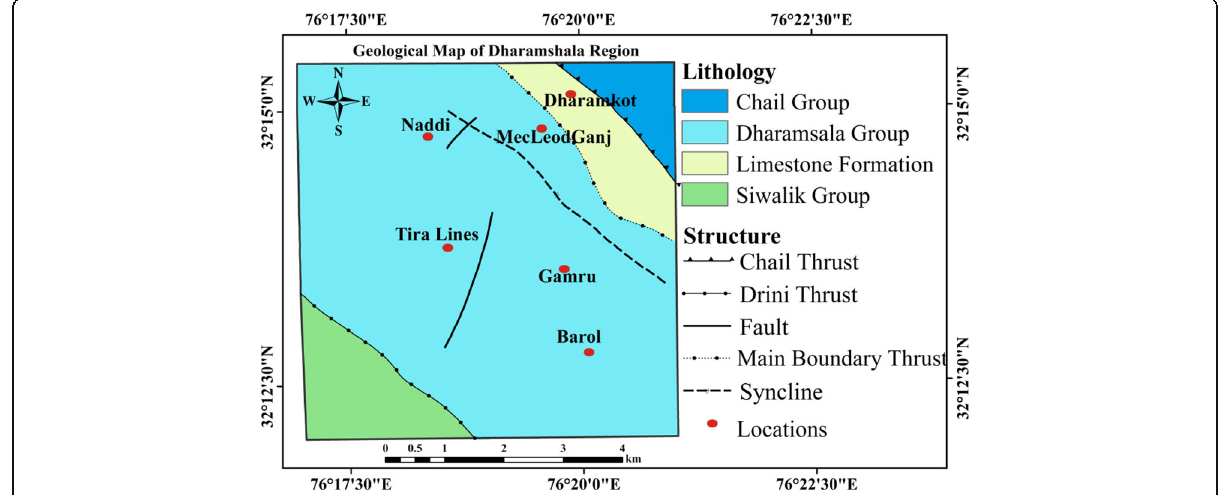
Fig. 2 Geological Map of Dharamshala region showing lithology and structure exposed (Source- Mahajan and Virdi